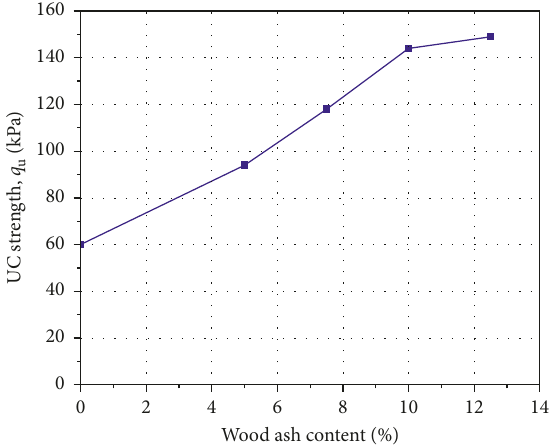
Figure 5: Variation of UCS with ash